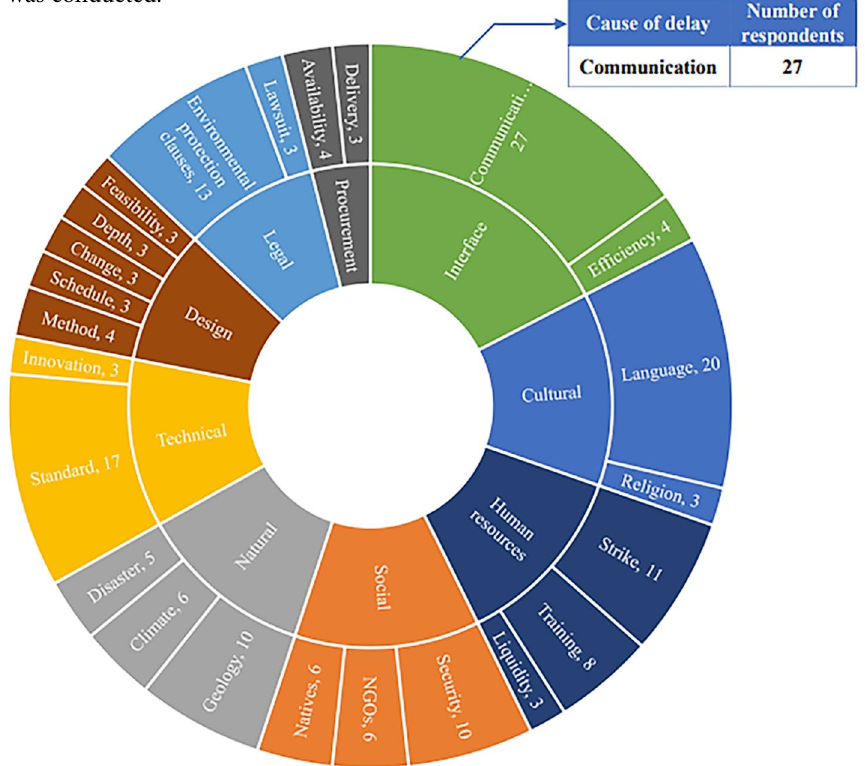
Figure 5. Sunburst chart describing the causes of time overrun through analysis of data obtaining in focus